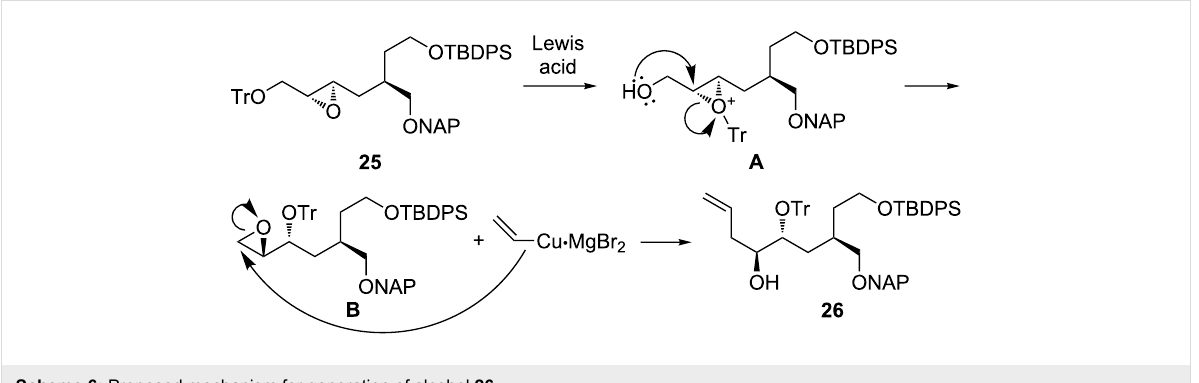
Scheme 6: Proposed mechanism for generation of alcohol 26